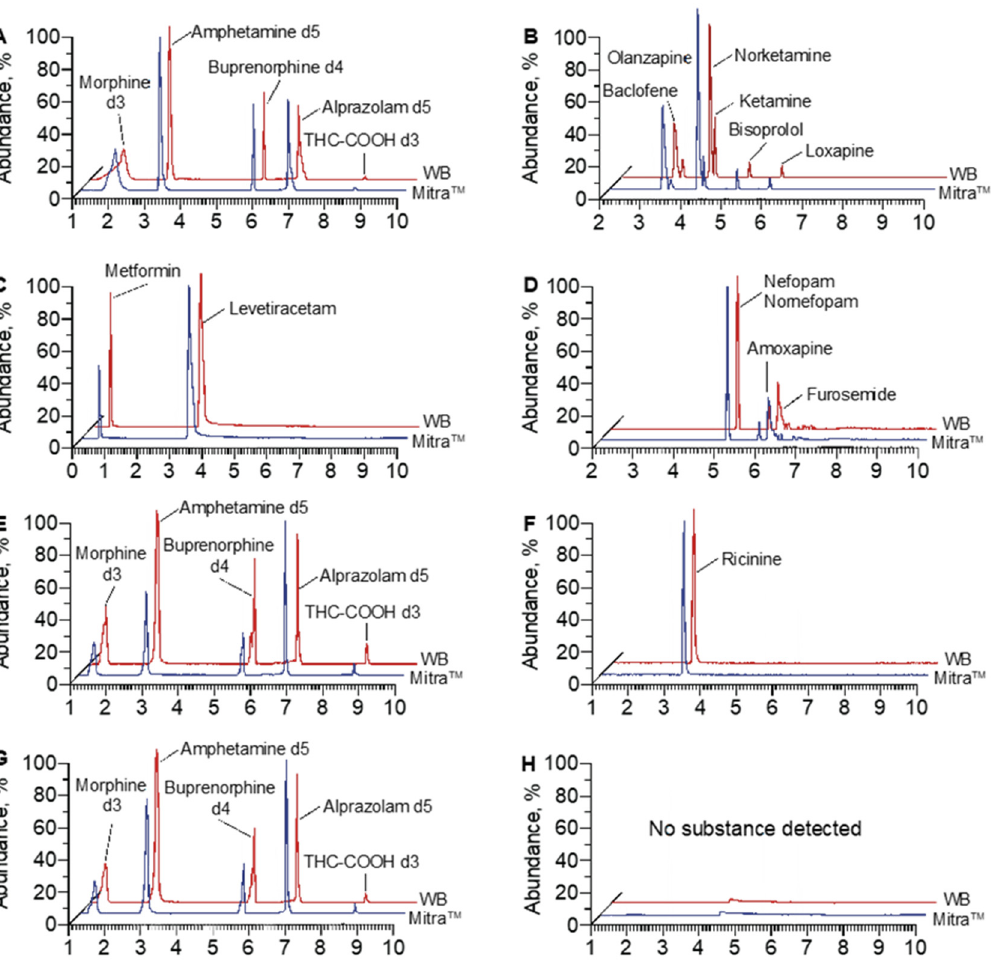
Figure 5. Examples of the chromatograms obtained for patient P2 (( A ) Internal Standards, ( B – D ) identi fi ed molecules), patient P12 (( E ) Internal Standards, ( F ) identi fi ed molecule) and patient P14 ( B – D ) identified molecules), patient P12 (( E ) Internal Standards, ( F ) identified molecule) and patient ( G ) Internal Standards, ( H ) identi fi ed molecule) after extraction using Mitra TM devices. P14 ( G ) Internal Standards, ( H ) identified molecule) after extraction using Mitra TM